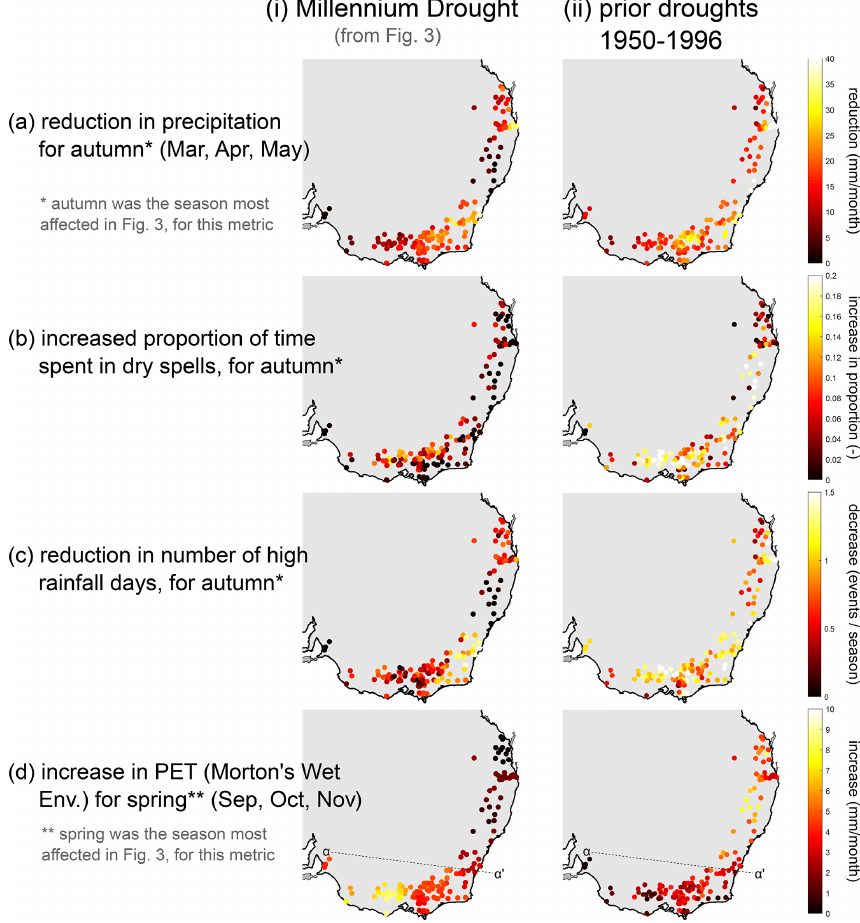
Figure 5. Changes compared to the long-term average (1950–2017) for (i) the Millennium Drought and (ii) prior droughts (selected from the period 1950–1996, inclusive), allowing HPEs to be assessed by temporal consistency. Variables and definitions are the same as in Fig. 3. Prior droughts refer to a set of years chosen separately for each catchment from the period 1950–1996. Years are selected if their rainfall was less than the average over the Millennium Drought (1997–2009). If this selects more than one-quarter of years in the period 1950–1996, then the selection is limited to the driest quartile (12 years). This selection process chooses a different number of years for each catchment, as shown in Fig. E1. Line α - α ’ is mentioned in Table